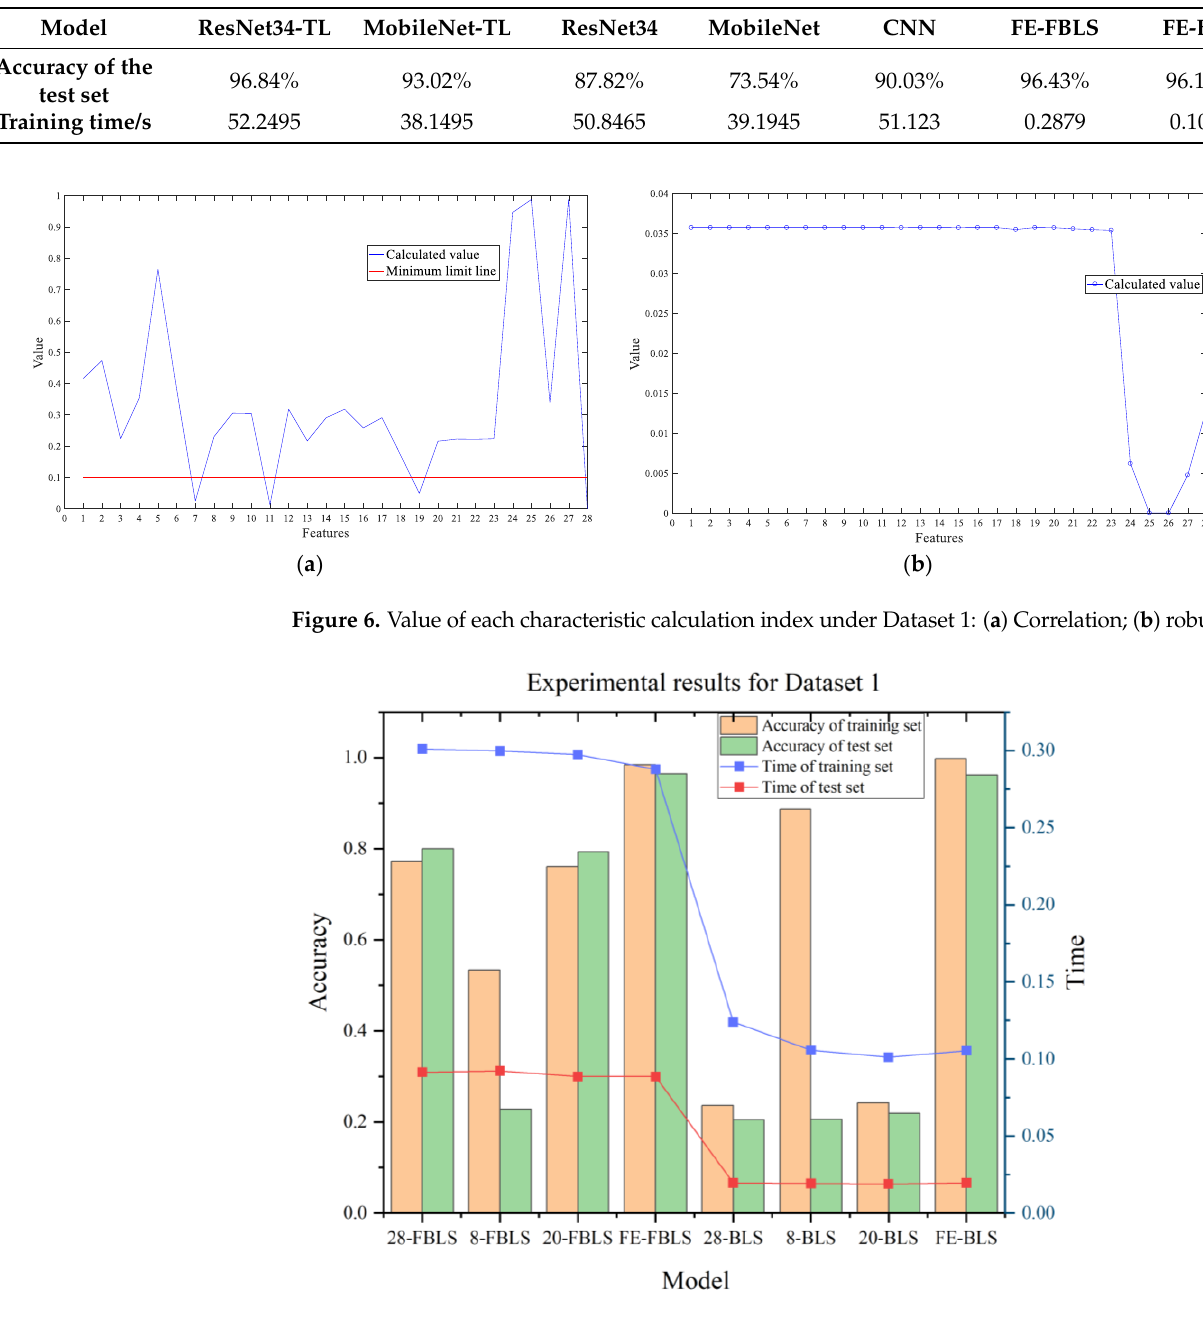
Table 2. Comparison of each classification model.